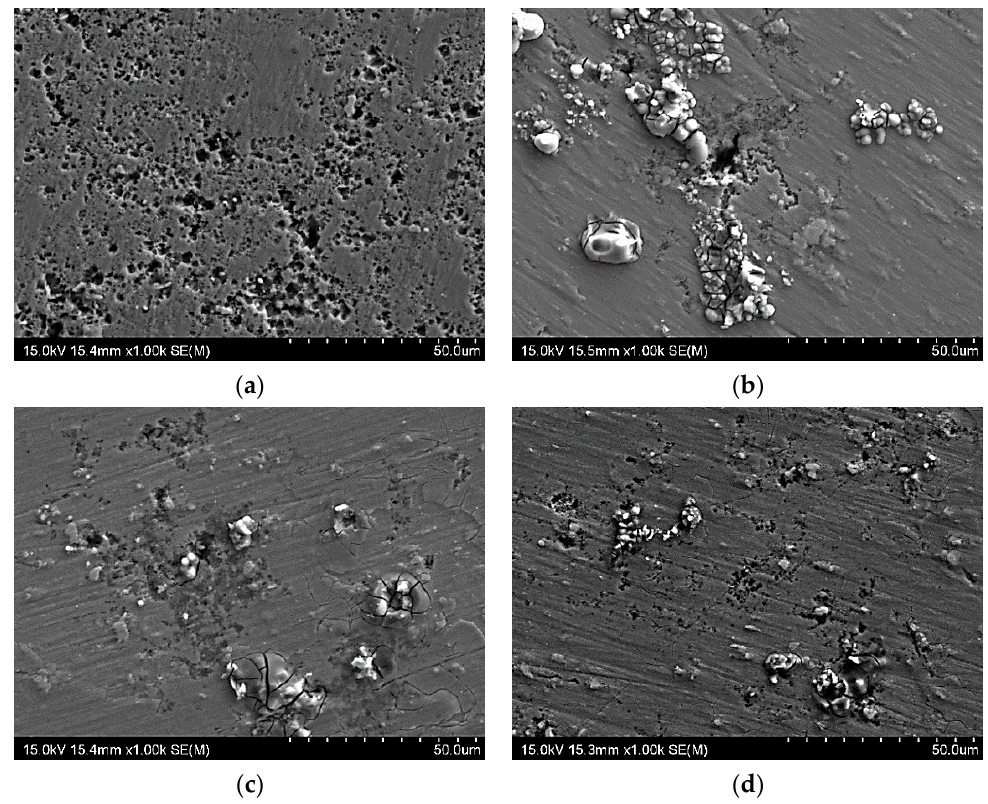
Figure 12. Sample surfaces following potentiodynamic polarization in 0.05 M NaCl: ( a ) CG, ( b ) HE, ( c ) HT1, and ( d ) HT2.